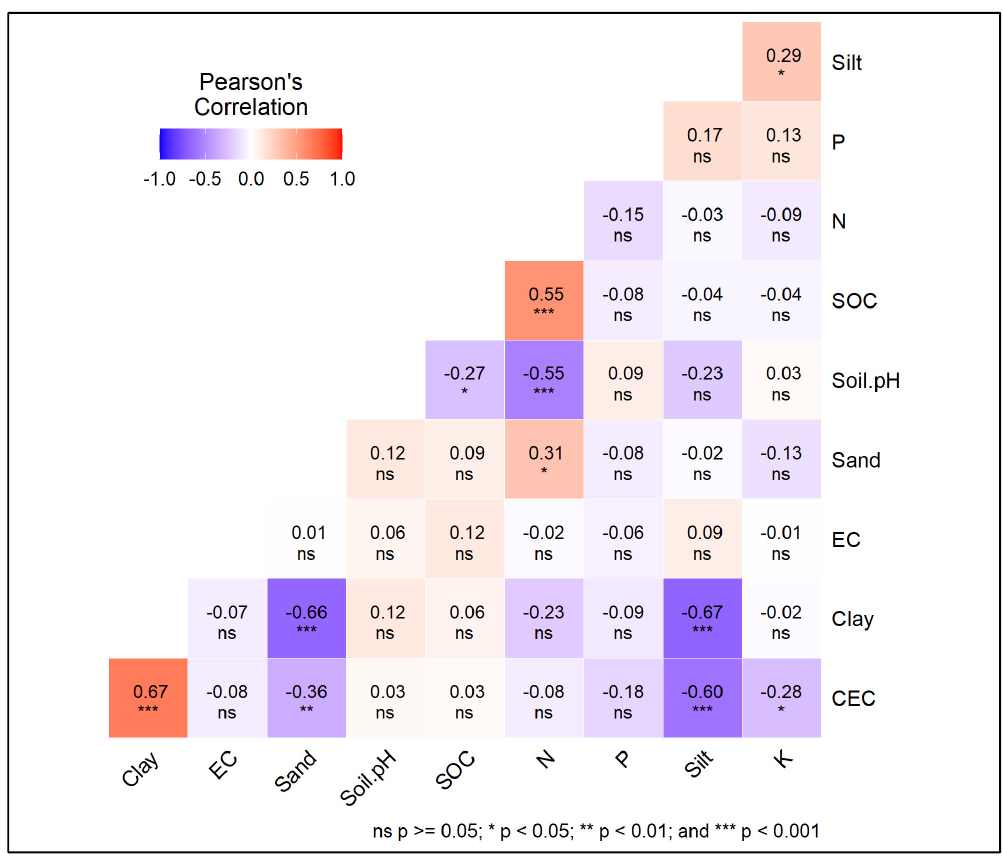
Figure 8. Ternary plot showing the distribution of five woody vegetation communities in semi- arid lowlands of Kasur, Punjab Pakistan. Ternary plot based on soil texture (silt, clay, and sand). (See Figure 5 description for full name of woody communities).